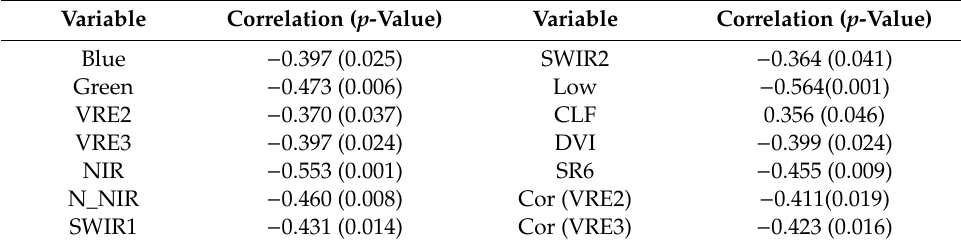
Table 4. Variables significantly correlated with low vegetation biomass.